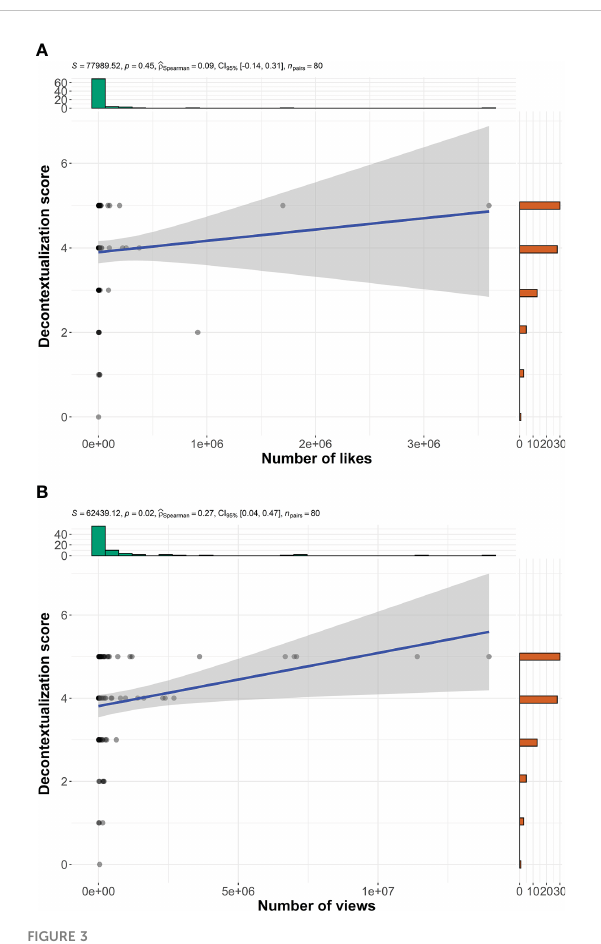
FIGURE 3 Spearman correlation plots representing the non-signi fi cant correlation between number of likes of loris videos on three social media platforms and decontextualization score (A) , and the signi fi cant positive correlation between number of views and decontextualization score (B)